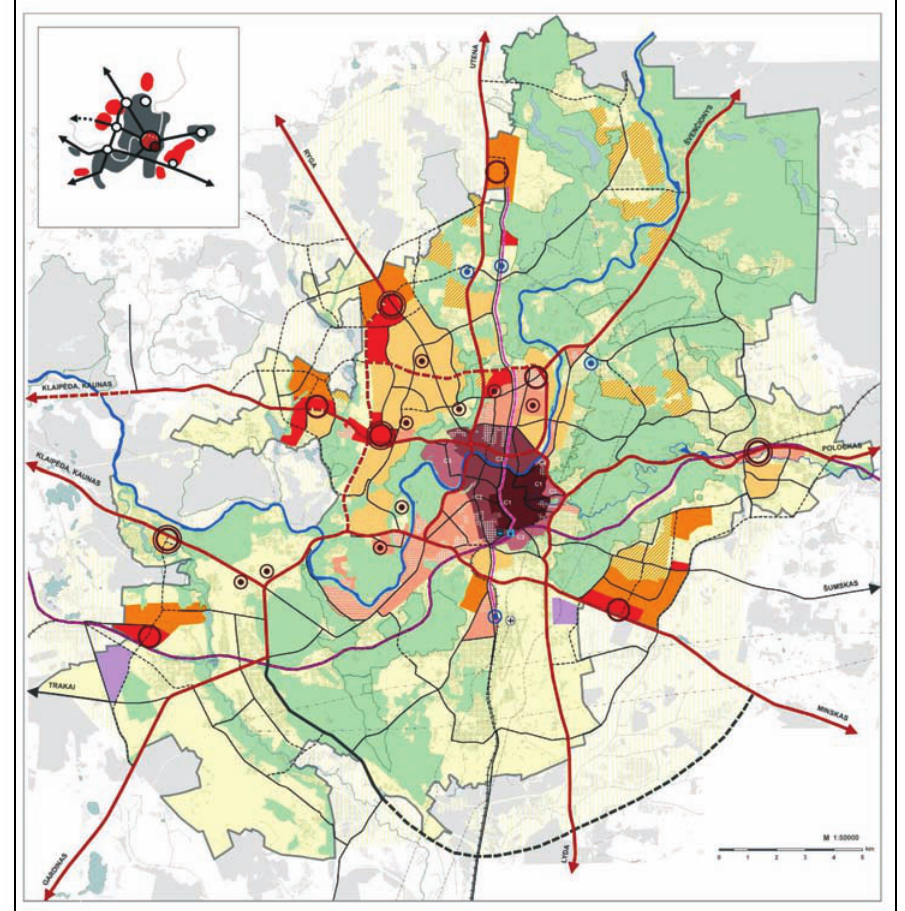
Fig 3. Vilnius city Master plan till 2015 (conception)